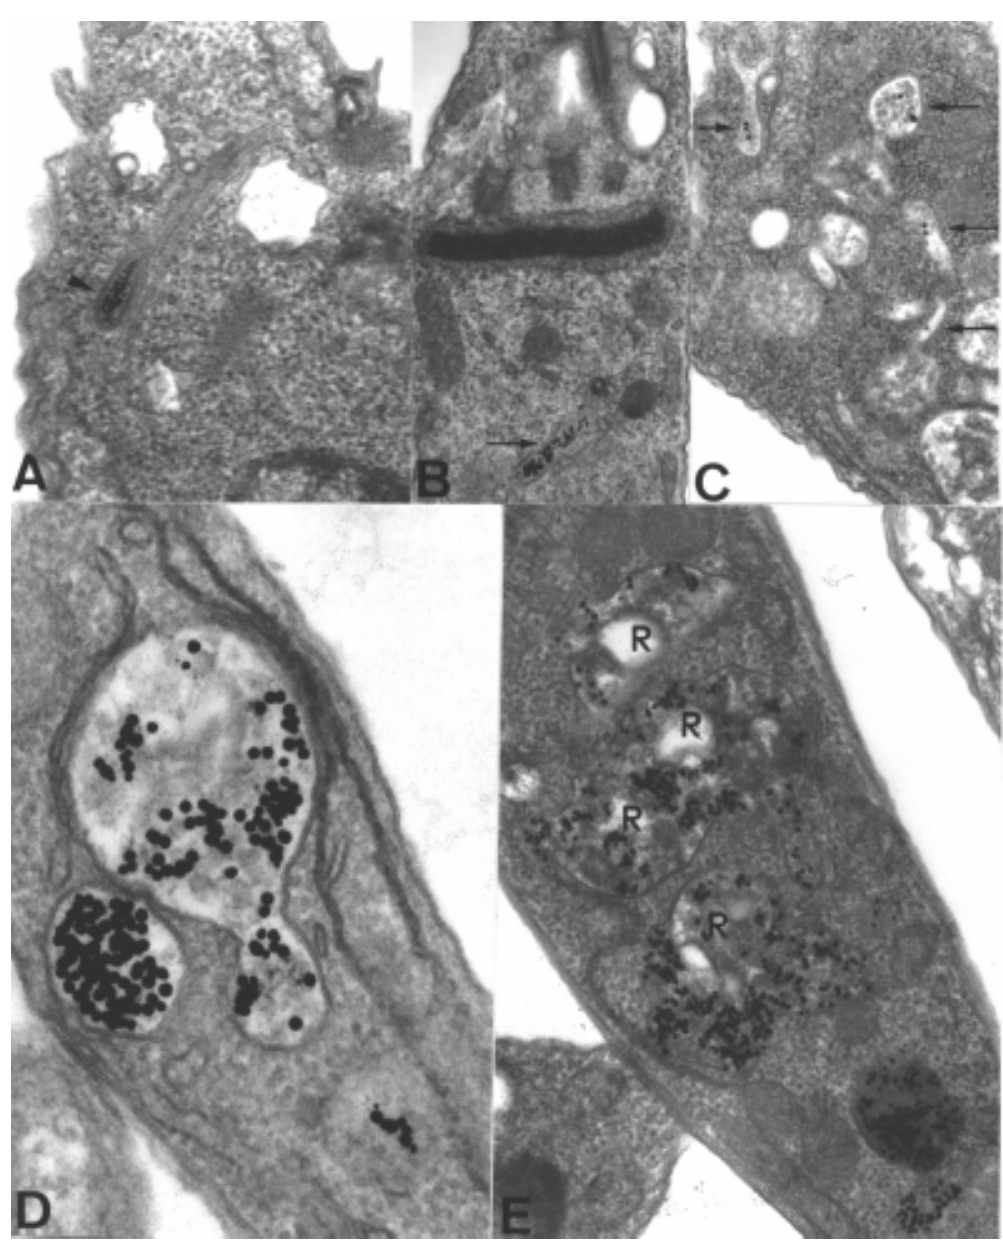
Fig. 4 – Epimastigotes internalize gold-labeled albumin: the tracer enters preferentially by the cytostome (A, arrowhead) and is subsequently found inside vesicles and tubules (arrows in B, 2 minutes of uptake; C, 5 minutes; D, 15 minutes), accumulating in reservosomes (R) after 30 minutes (E). (A) X 34,800 (B) X 31,300 (C) X 25,200 (D) 78,300 (E) X 34,800.